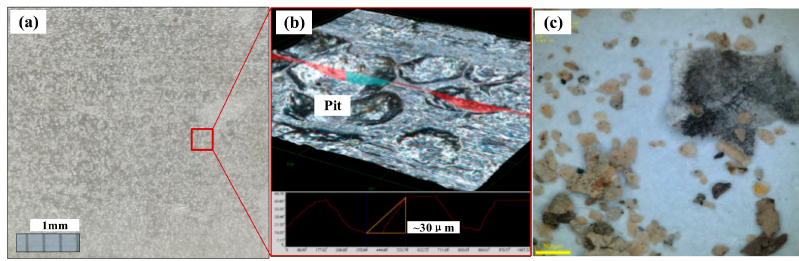
Figure 5. Typical surface micro-morphology after cleaning at 1 (cid:13) in area A: ( a ) 2D view; ( b ) 3D view and measured value; ( c ) the exfoliation collected after laser